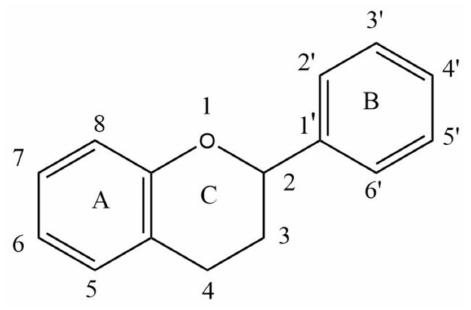
Figure 1. Basic structure of a